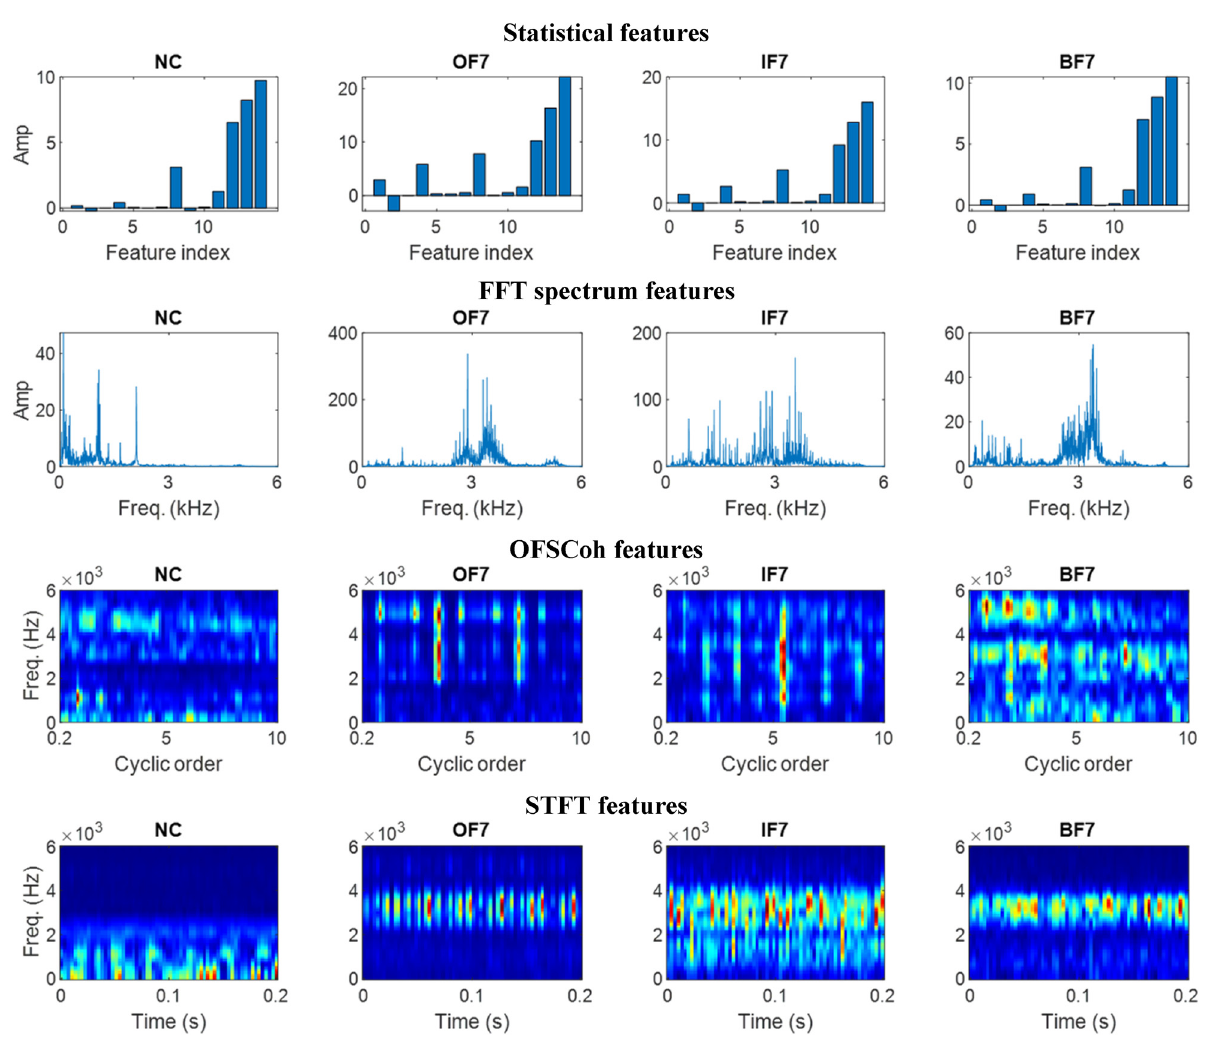
Figure A2. The Statistical, FFT spectrum, OFSCoh, and the STFT features of bearing dataset at 1 hp.